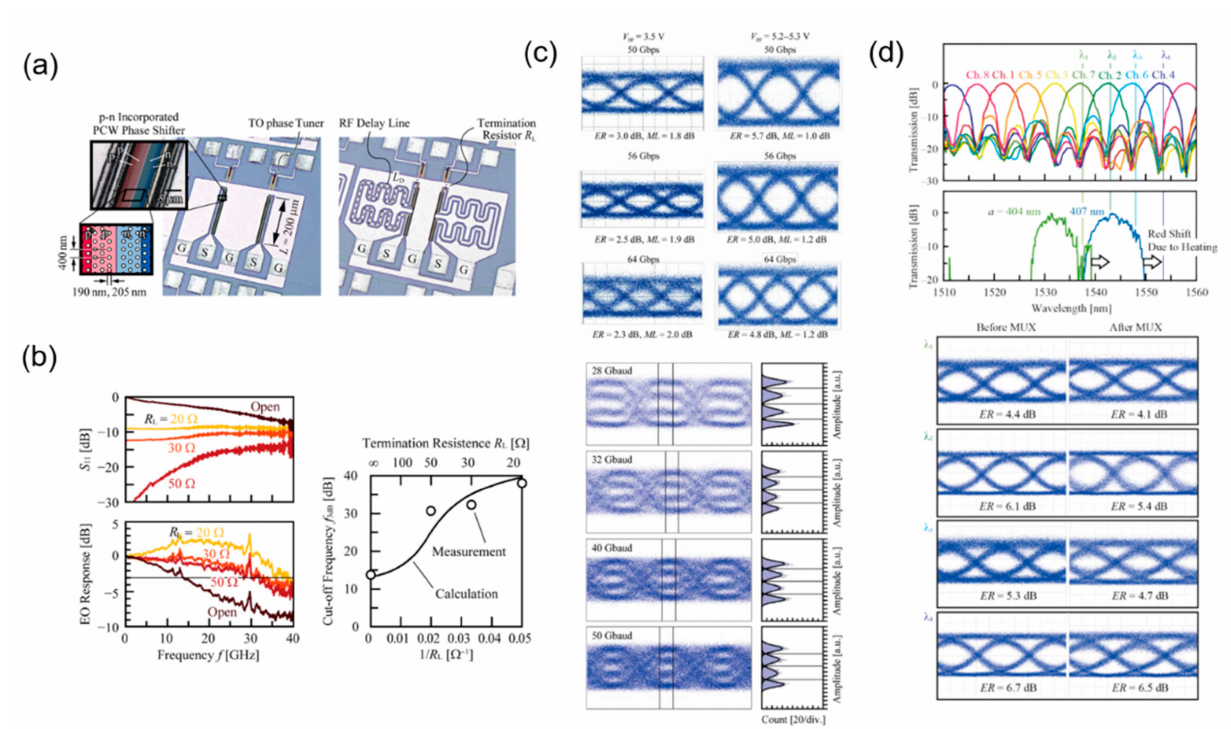
Figure 8. Silicon photonic crystal modulator with the meander line electrodes. ( a ) The optical image of the silicon photonic crystal modulator with the normal electrodes and the meander line electrodes [49]. ( b ) EO response of silicon photonic crystal modulator with the meander line electrodes [49]. ( c ) OOK eye diagrams of 50 Gb/s, 56 Gb/s, and 64 Gb/s and PAM4 eye diagrams of 28 Gbaud, 32 Gbaud, 40 Gbaud, and 50 Gbaud [50]. ( d ) Measurement results of WDM transmission experiment